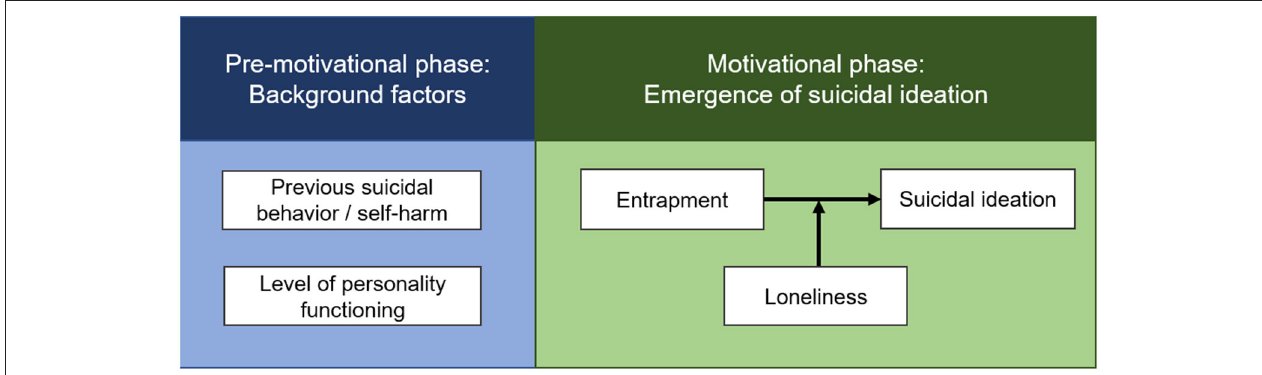
FIGURE 1 | Simplified depiction of the variables and associations that are the focus of the primary research goal. A reduced, specified version of the integrated motivational-volitional model of suicide [IMV model; O’Connor and Kirtley (12)] will be tested in the context of the project. The IMV model differentiates three phases: First, the pre-motivational phase describes the broader context of suicidal crises over the life span. Second, in the motivational phase, suicidal ideation is conceptualized as the result of the dynamic interplay of distressing emotional states and moderating factors that determine an individual’s ability to cope with them. Lastly, the transition to suicidal behavior—the volitional phase—is shaped by further, specific risk factors (the volitional phase is not depicted here as the project focuses on suicidal ideation). All motivational phase variables will be assessed using Ecological Momentary